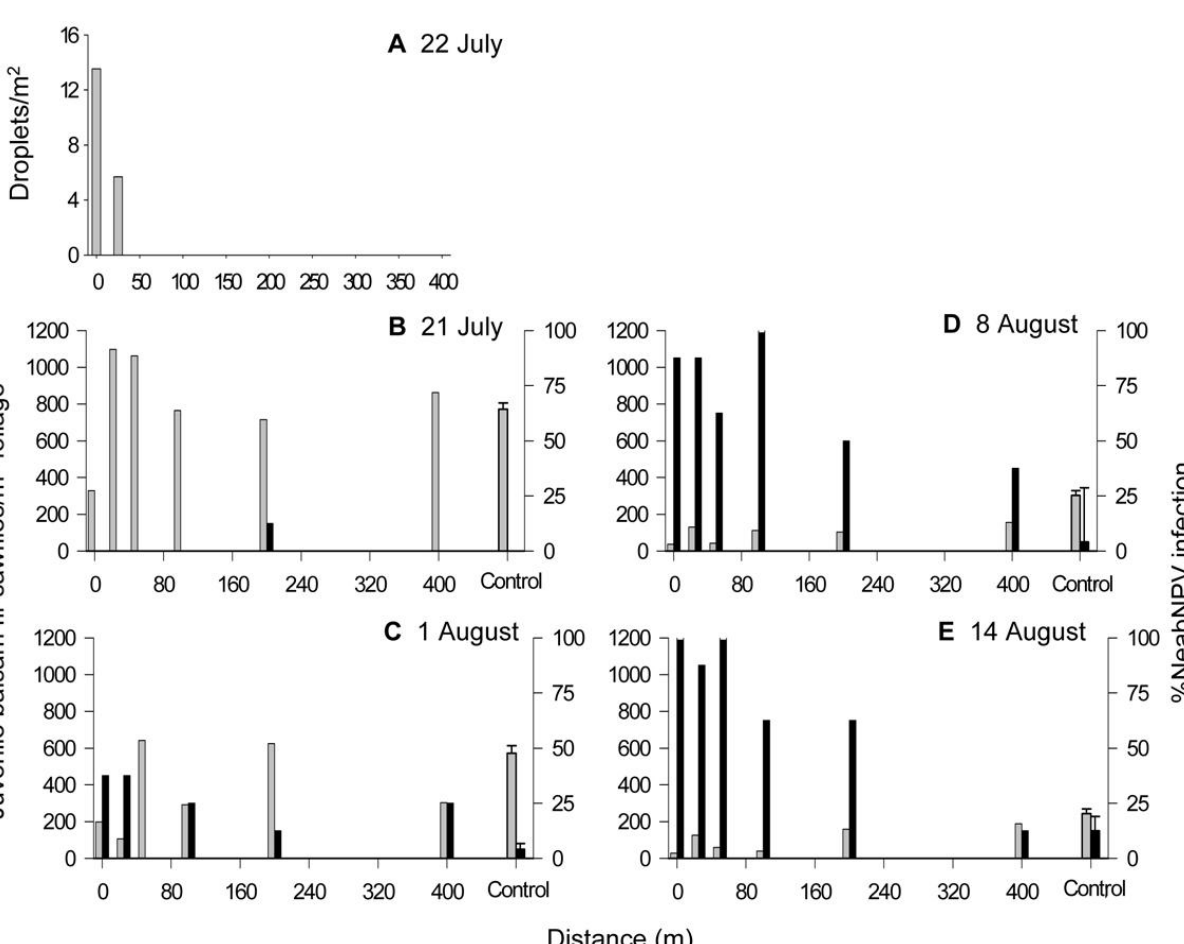
Figure 3. ( A ) Mean spray deposit along two transect lines extending 400 m out from the east and west sides of a 313-ha treatment block at Island Pond following aerial application of NeabNPV on 22 July 2002. Juvenile balsam fir sawfly (larvae and pupae) density (gray bars) and mean prevalence of NeabNPV infection (black bars) in the treatment block and the untreated control block on ( B ) 21 July, ( C ) 1 August, ( D ) 8 August, and ( E ) 14 August 2002. The densities and infection in the control plots are represented as a mean value (±SEM) because they exhibited no discernable consistent pattern along the